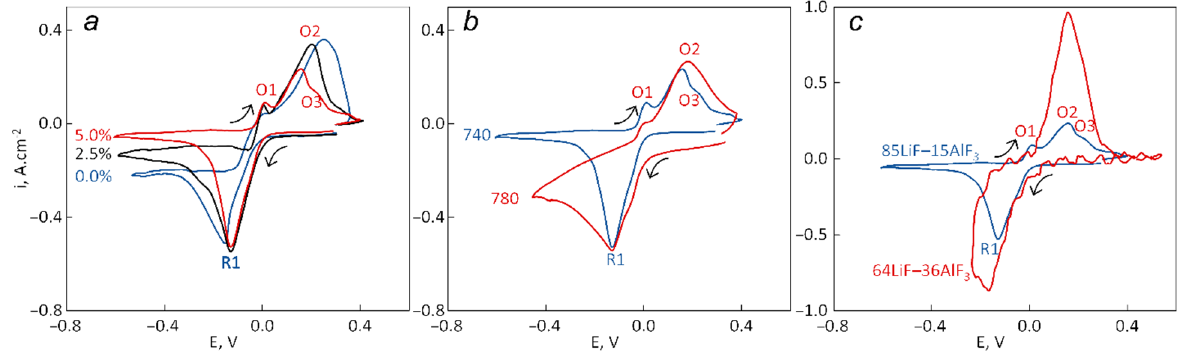
Figure 6. Comparison of the CVs recorded for tungsten at a scan rate of 0.025 V ∙ s − 1 : ( a ) in 85LiF–15AlF 3 at 740 °C (with 0– 5 wt.% of spent catalyst); ( b ) in 85LiF–15AlF 3 at 740 and 780 °C with 5 wt.% of spent catalyst; ( c ) in 85LiF–15AlF 3 and 64LiF–36AlF 3 at 740 °C with 5 wt.% of spent catalyst.